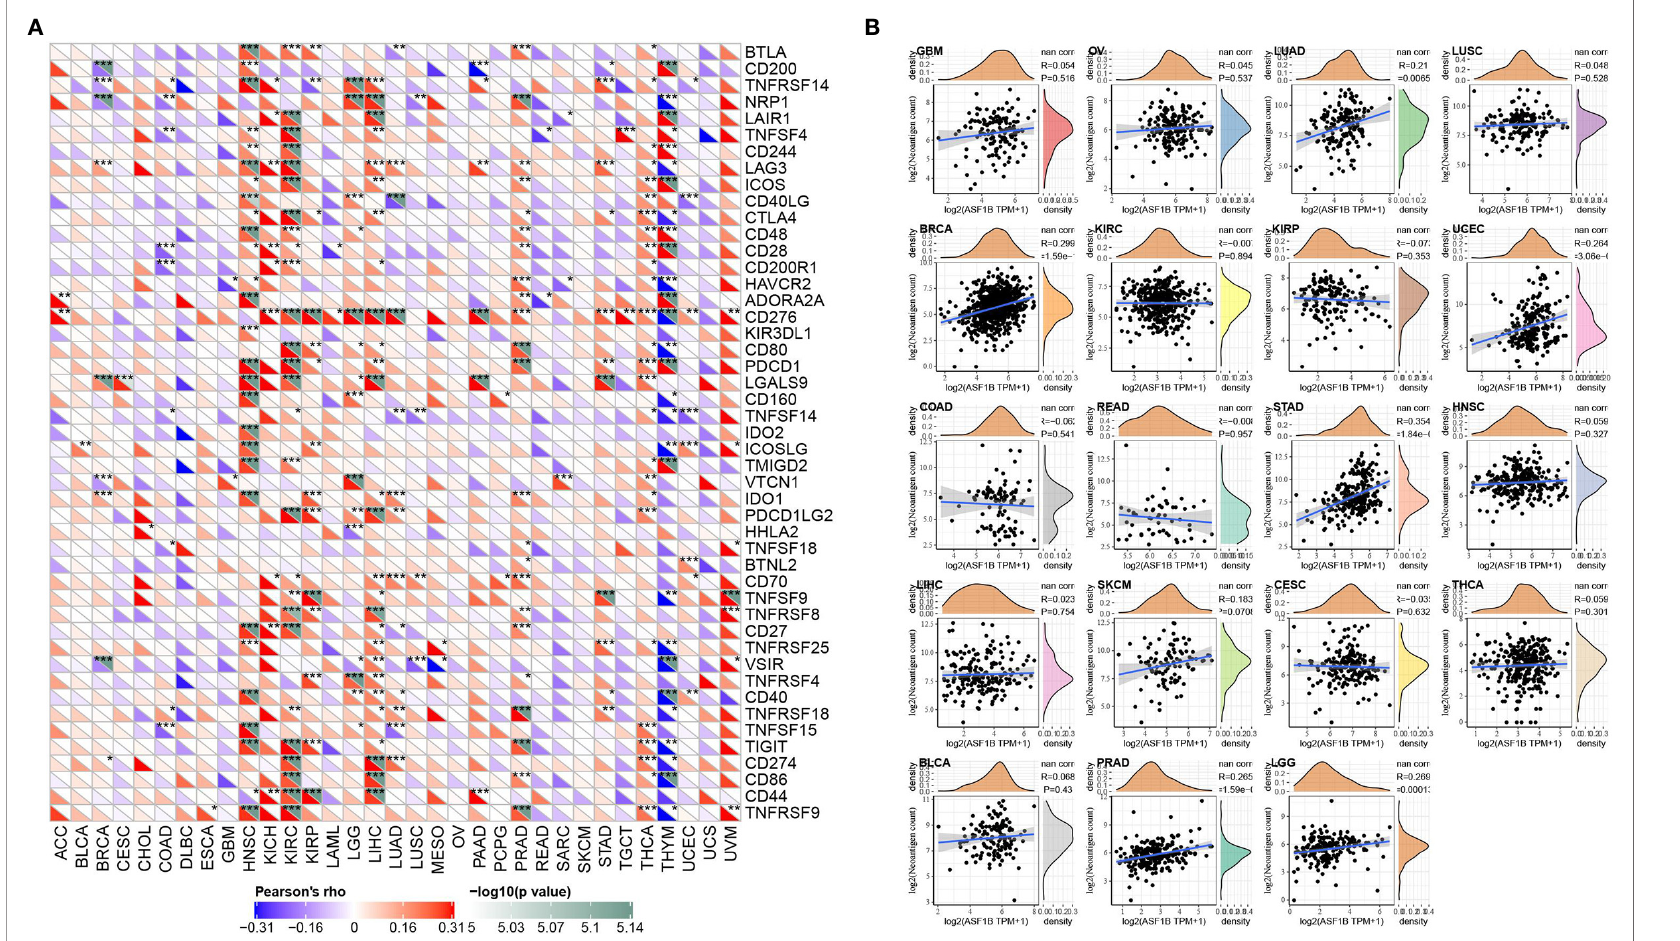
FIGURE 6 | Correlation analysis of ASF1B expression in pan-cancer with immune neoantigens and immune checkpoint genes; (A) Correlation analysis of ASF1B expression in pan-cancer with immune checkpoint gene expression; (B) Correlation analysis of ASF1B expression in 19 tumors with the number of tumor neoantigens. In (A) * is P < 0.05, ** is P < 0.01 and *** is P <